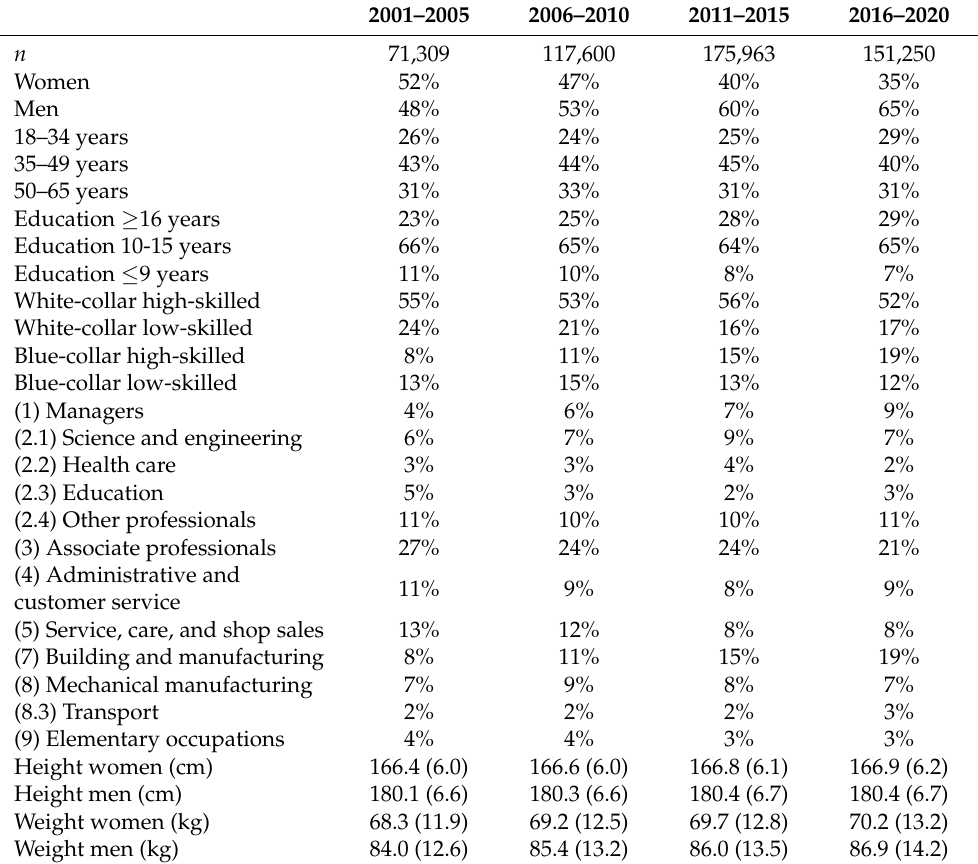
Table 1. Characteristics of the unadjusted sample divided into five-year